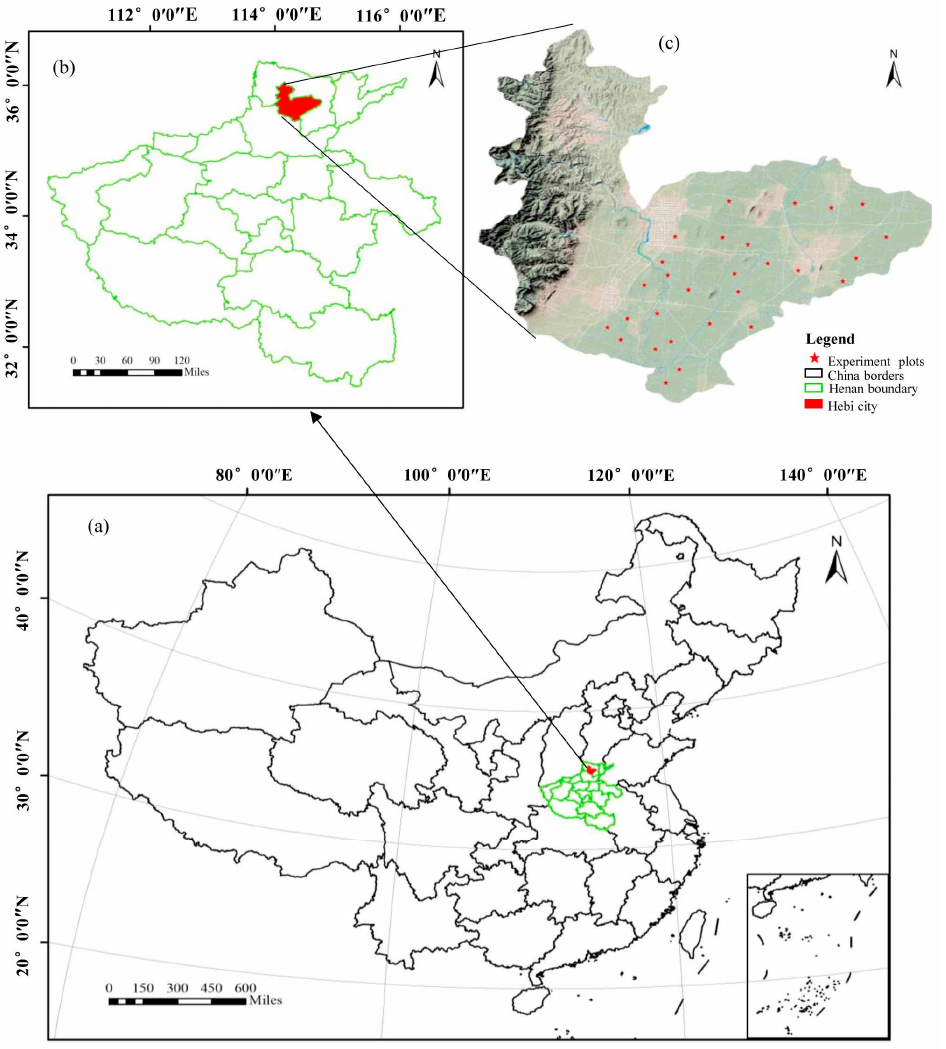
Figure 1. Overview of the study area and map showing the locations of the sampling sites.